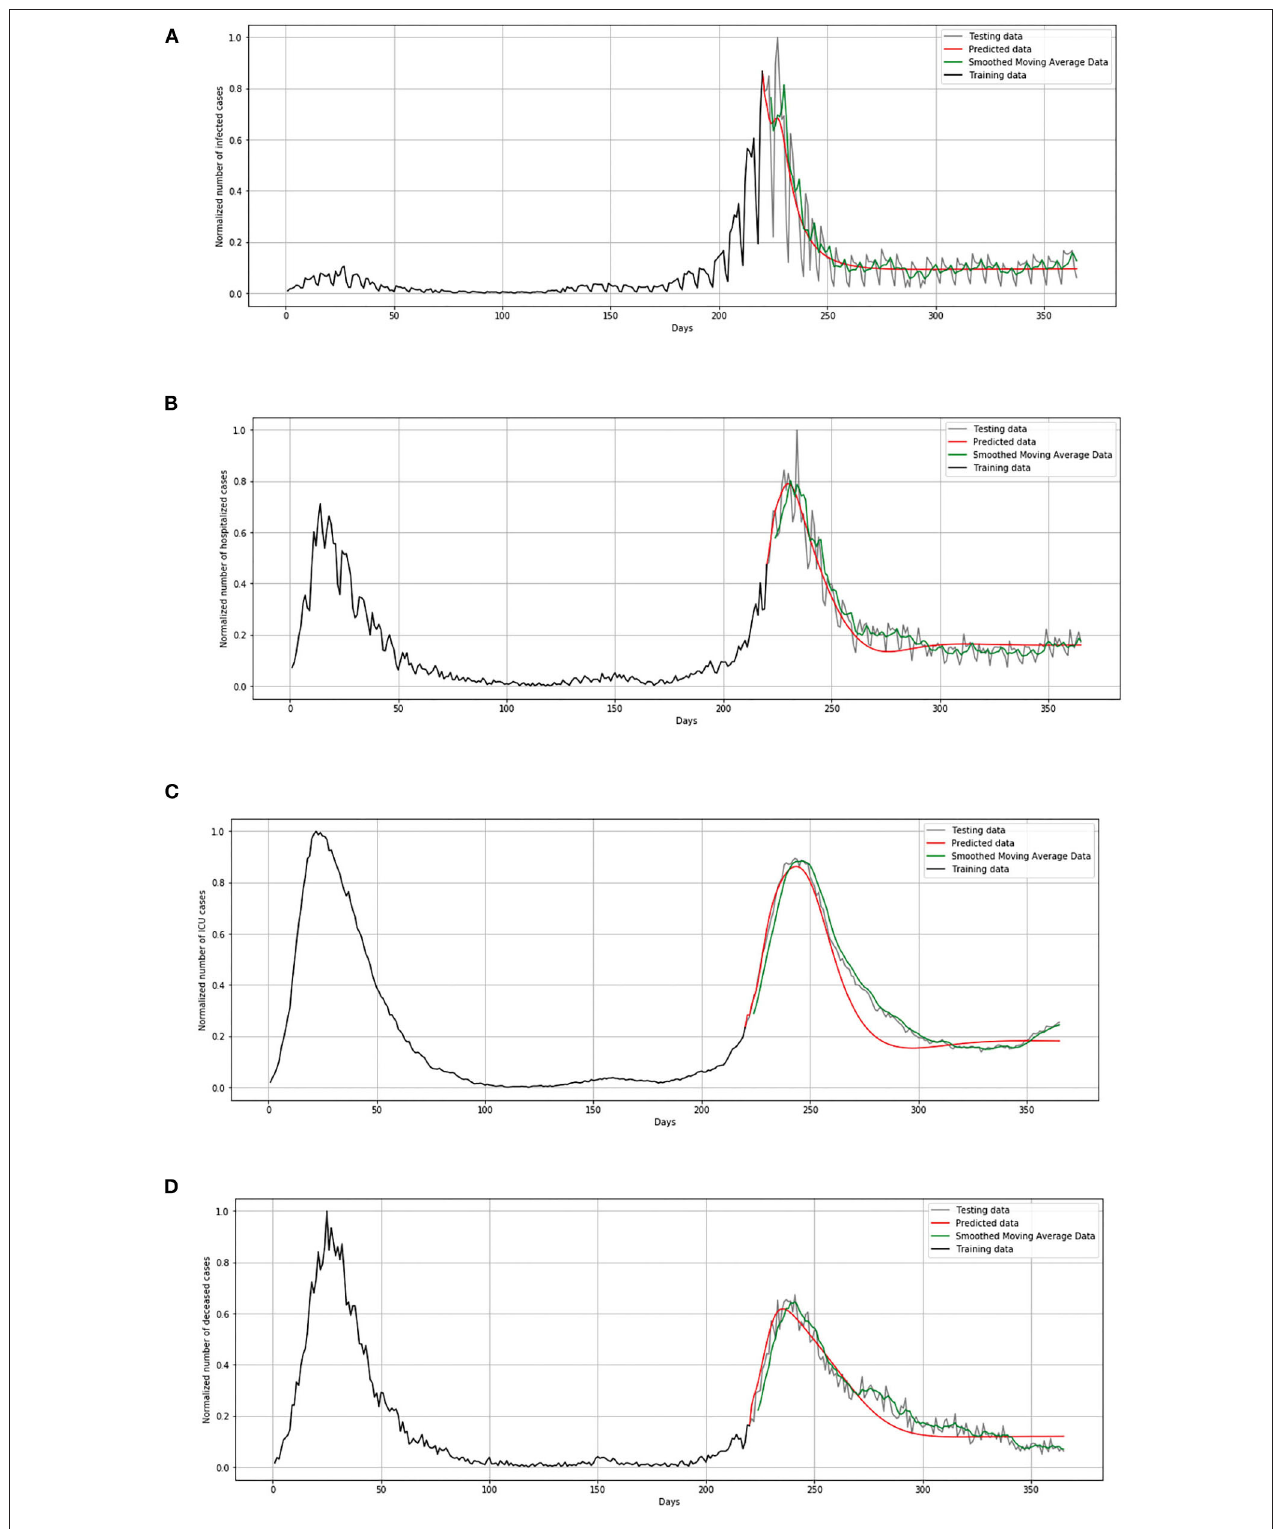
FIGURE 12 | Comparison of real and simulated values for Belgium: (A) number of infected cases, (B) number of hospitalized cases, (C) number of ICU cases, (D) number of deceased cases.